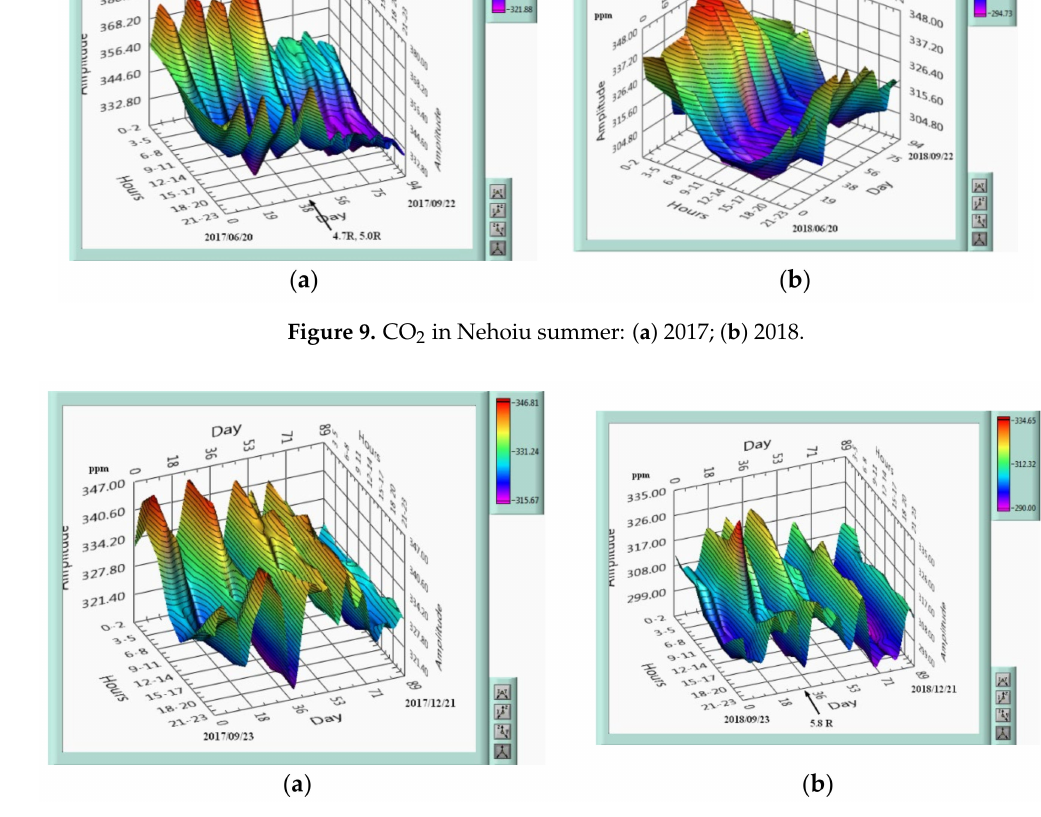
Figure 10. CO 2 in Nehoiu autumn: ( a ) 2017; ( b ) 2018.